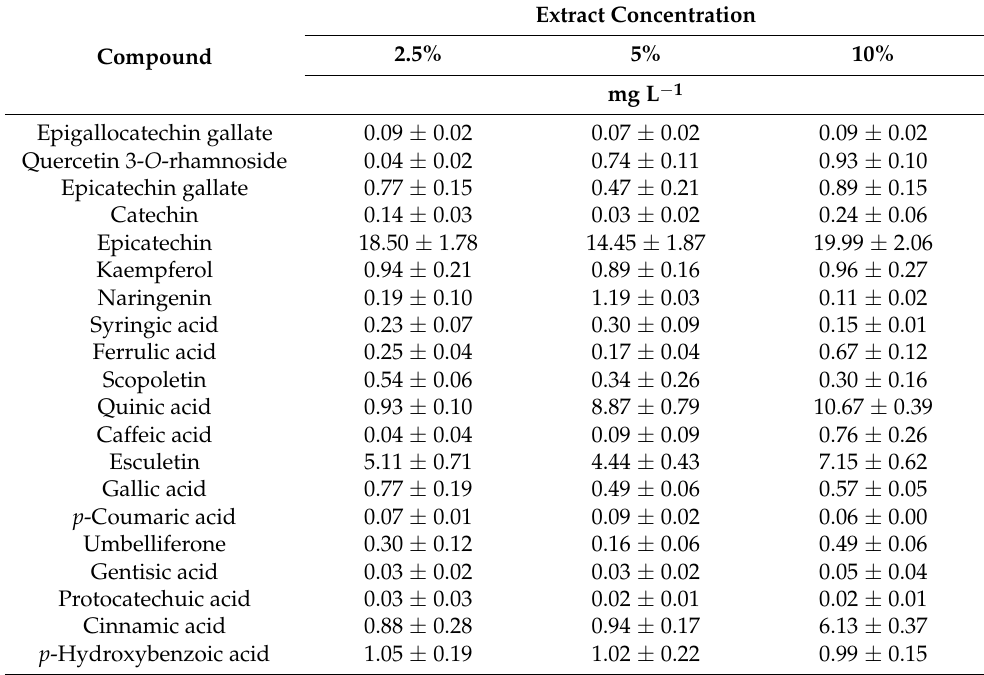
Table 4. Phytochemical composition of nettle ( U. dioica L.) aqueous extracts of different concentrations.